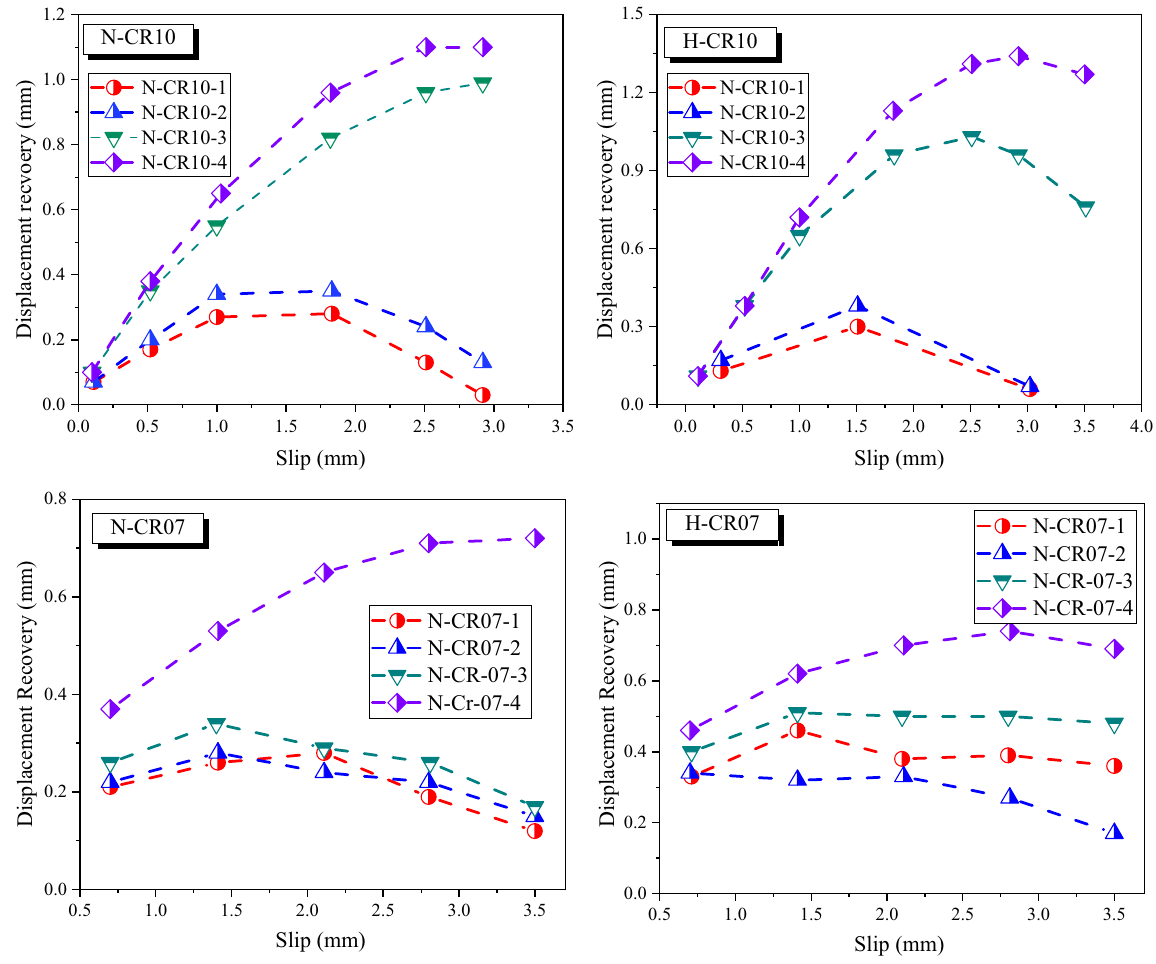
Figure 13: Displacement recovery of crimped SMA fi bers ( a ) N - CR10, ( b ) H - CR10, ( c ) N - CR07, and ( d ) H -